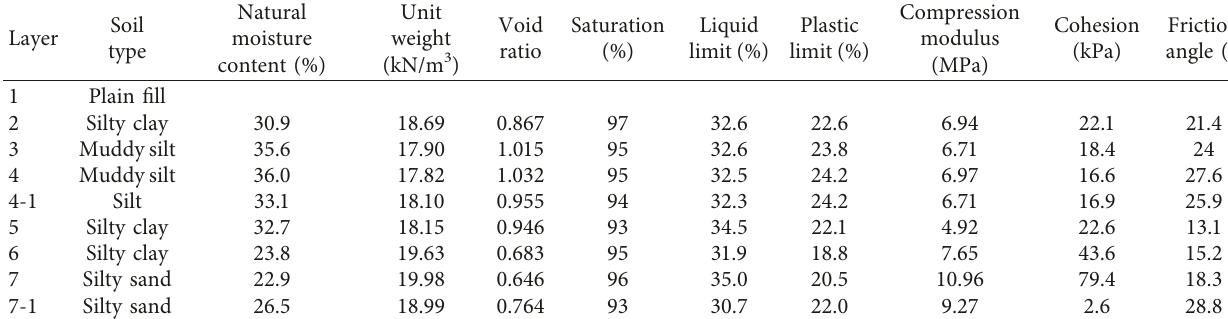
Table 1: Parameters of soil